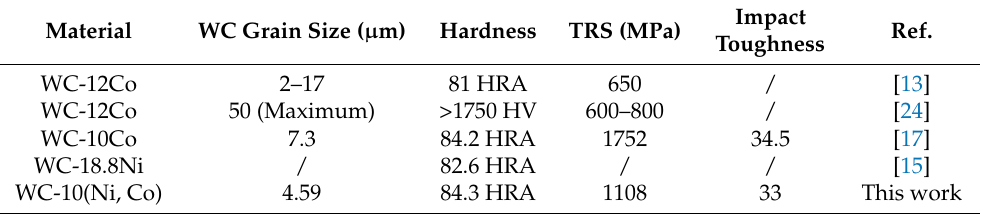
Table 4. Comparison of mechanical properties of traditional WC-based cemented